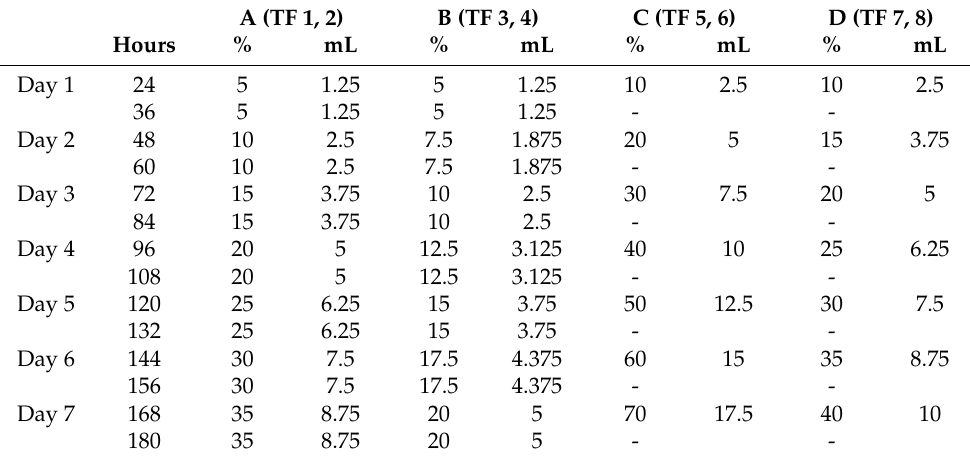
Table 1. Medium replacement scheme of the reference experiment indicating the percentage and volume of medium replaced at each time point, where a 100% medium replacement is equal to 25 mL.